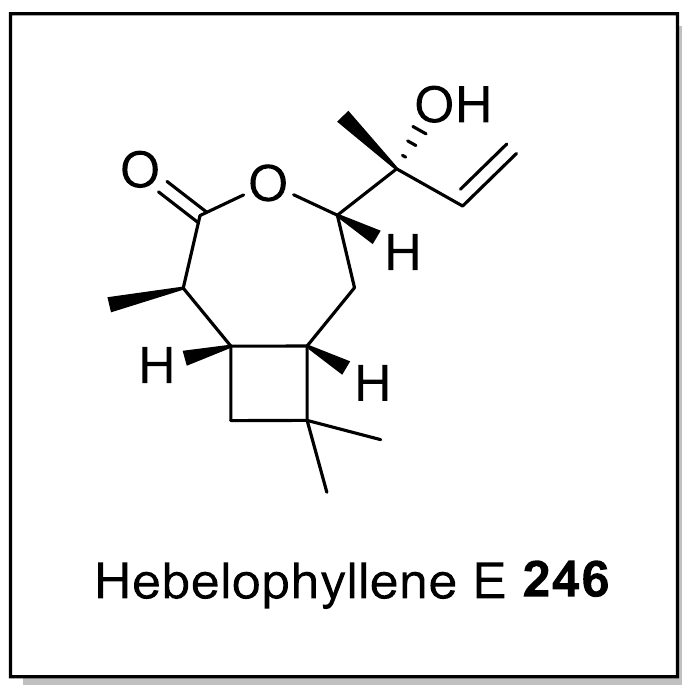
Figure 7. Structure of hebelophyllene E 246 .